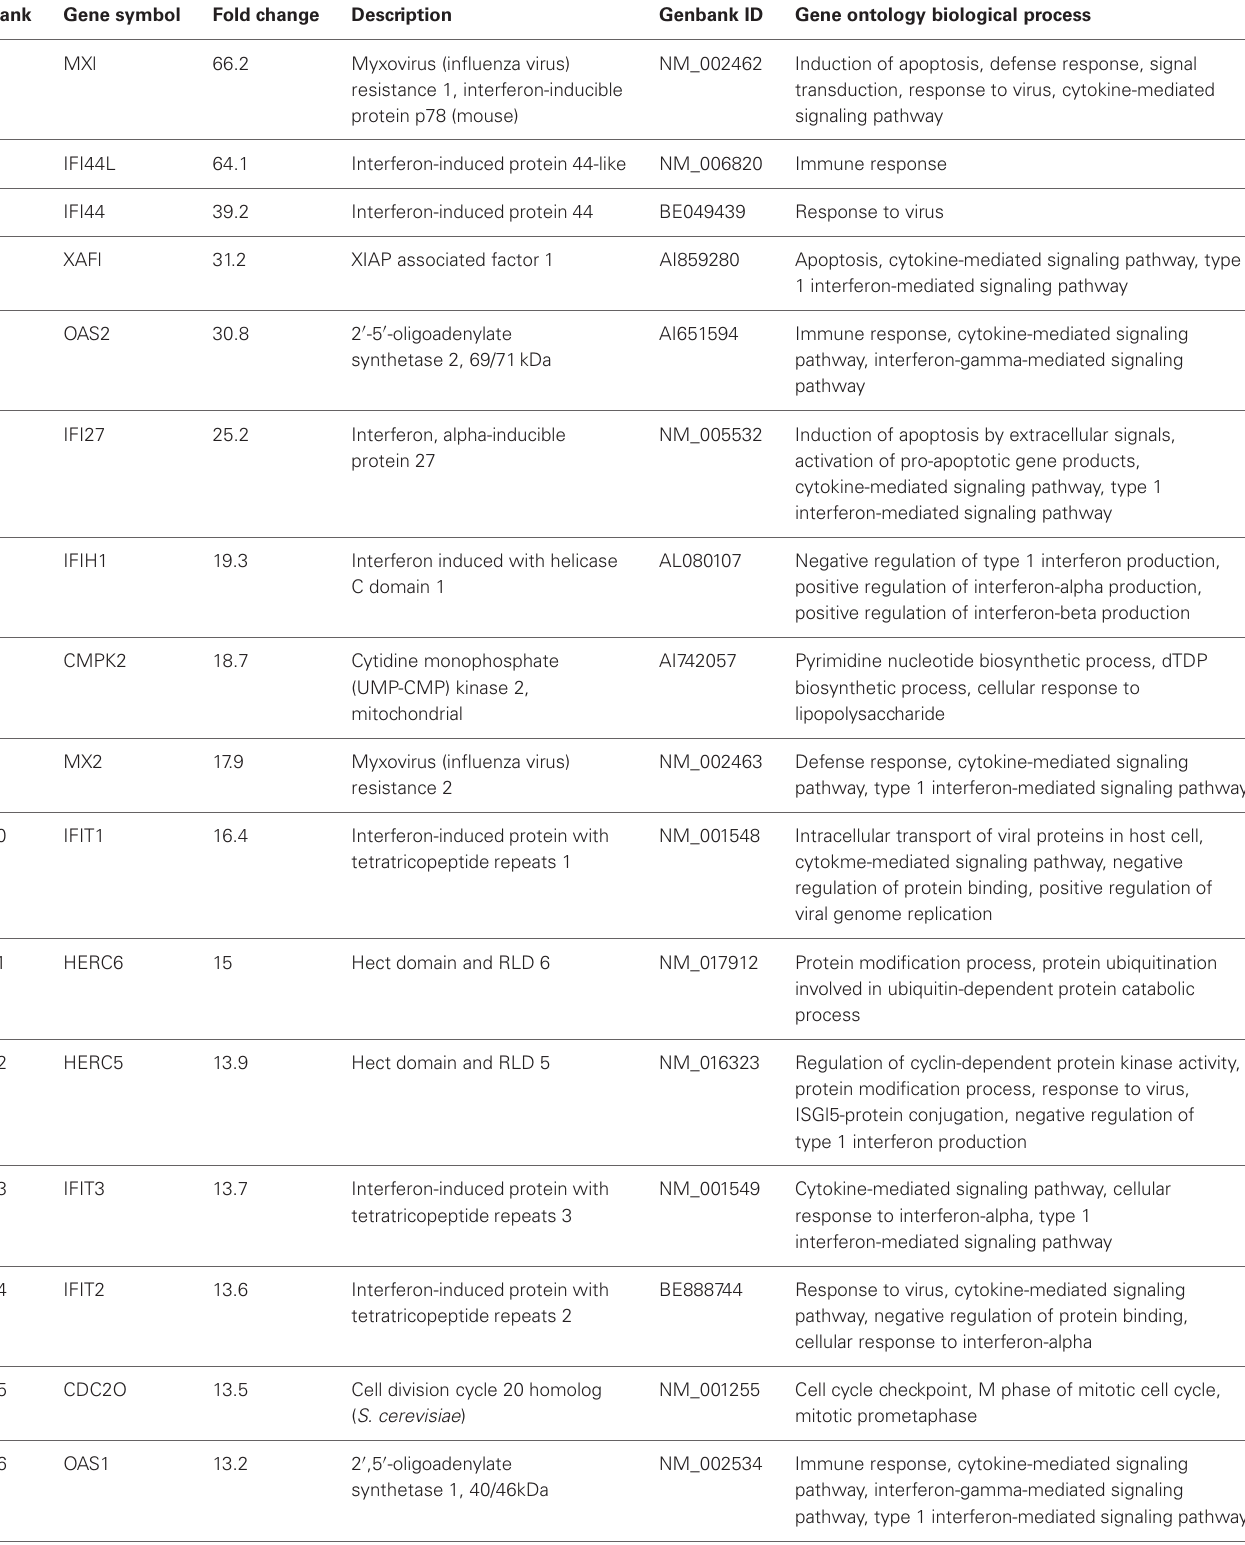
Table 1 | Top 30 genes modulated in bronchial epithelial cells in response to exposure to Alternaria alternata spores.